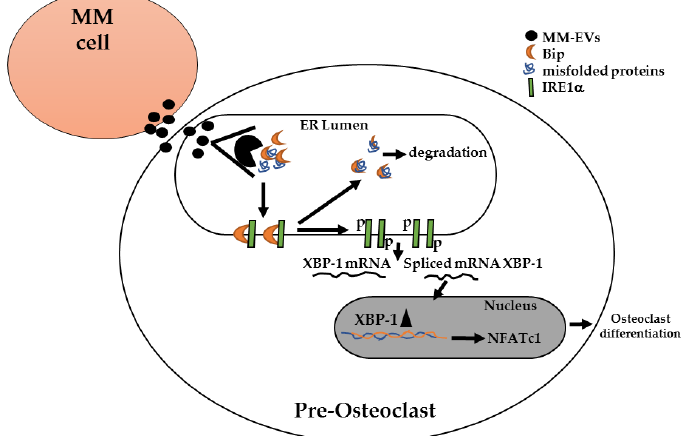
Figure 7. MM cells secrete EVs containing UPR-related molecules (as Bip proteins) and misfolded proteins; once internalized inside pre-osteoclast cells, MM-EVs are likely addressed to the ER, where they could release their cargo. Misfolded proteins are bound by BiP proteins, both endogenous and exogenous, allowing the dimerization and autophosphorylation of IRE1α. Activated IRE1α mediates the splicing of XBP1 mRNA, the nuclear translocation of XBP1 protein and the activation of NFATc1 gene expression, a key regulator of OC differentiation.